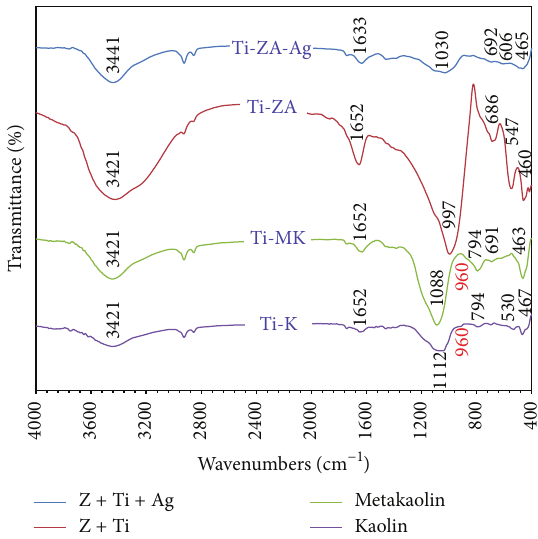
Figure 1: FTIR for the parent Kaolin before (Ti-K) and after (Ti- MK) calcination, Ti-Zeolite Na-A before (Ti-Z-A) and after silver substitution